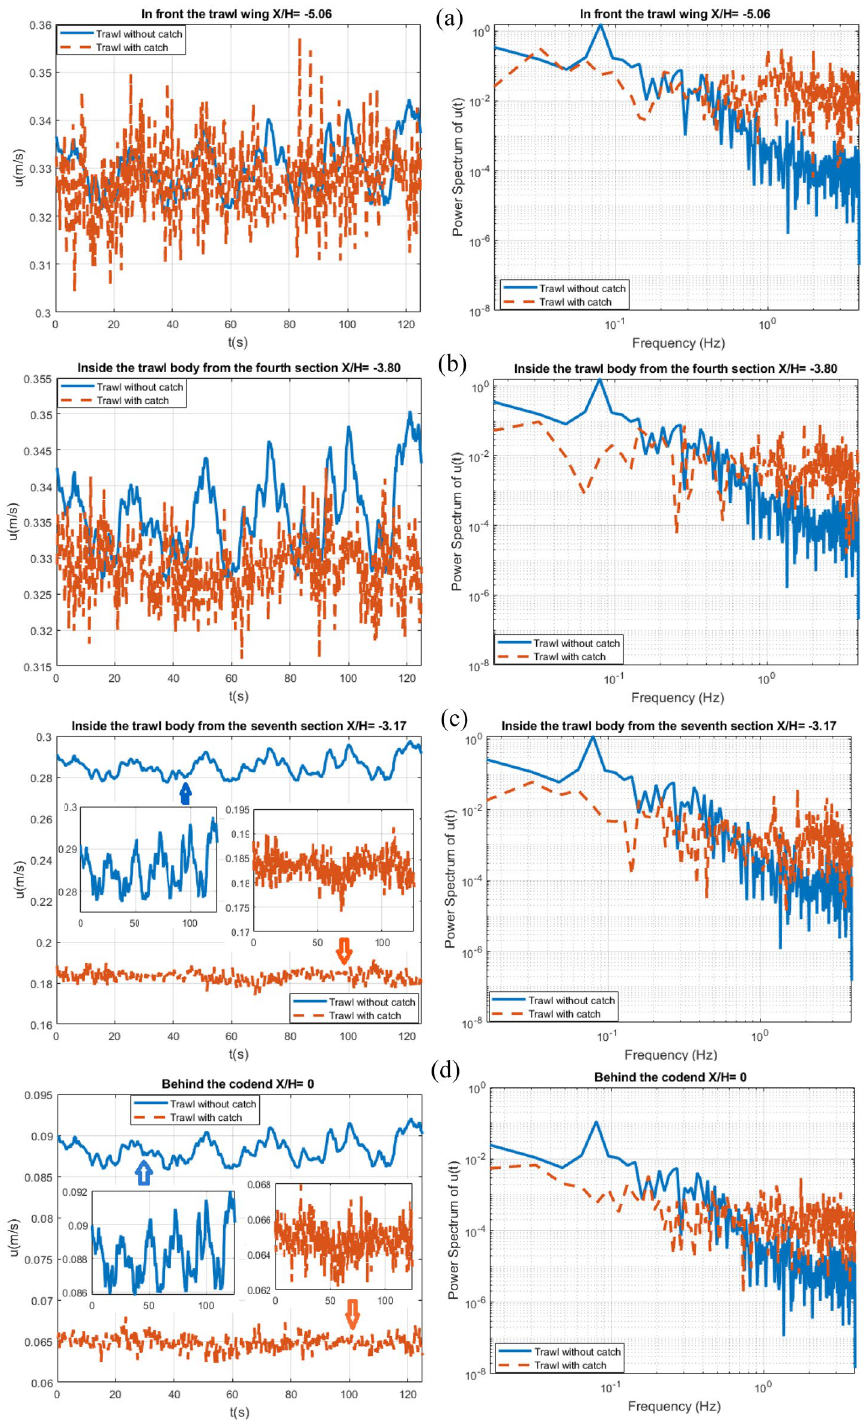
Figure 12. Time evolution of the streamwise velocity (right) linked to the normalized frequency spectrum (left in a log–log scale) at ( Y/H = 0 and Z/H = 0.506 ) represented as: ( a ) In front of the trawl wing ( X/H = − 5.06) , ( b ) Inside the fourth section of trawl body ( X/H = − 3.80) , ( c ) Inside the seventh section of trawl body ( X/H = − 3.17) , and ( d ) Behind the codend ( X/H =